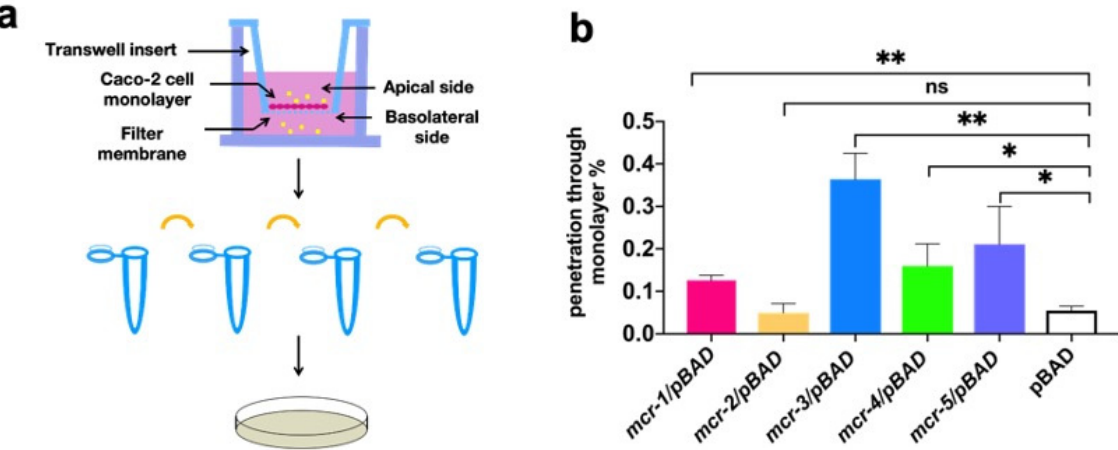
Figure 4. Bacterial virulence evaluated using trans-well assays and G. mellonella . ( a ) Study design of the trans-well assay. ( b ) Percentage of MCR-expressing strains that passed through the Caco-2 cell monolayer at 2 h measured by viable counting. * p < 0.05, ** p < 0.01, ns: not significant.